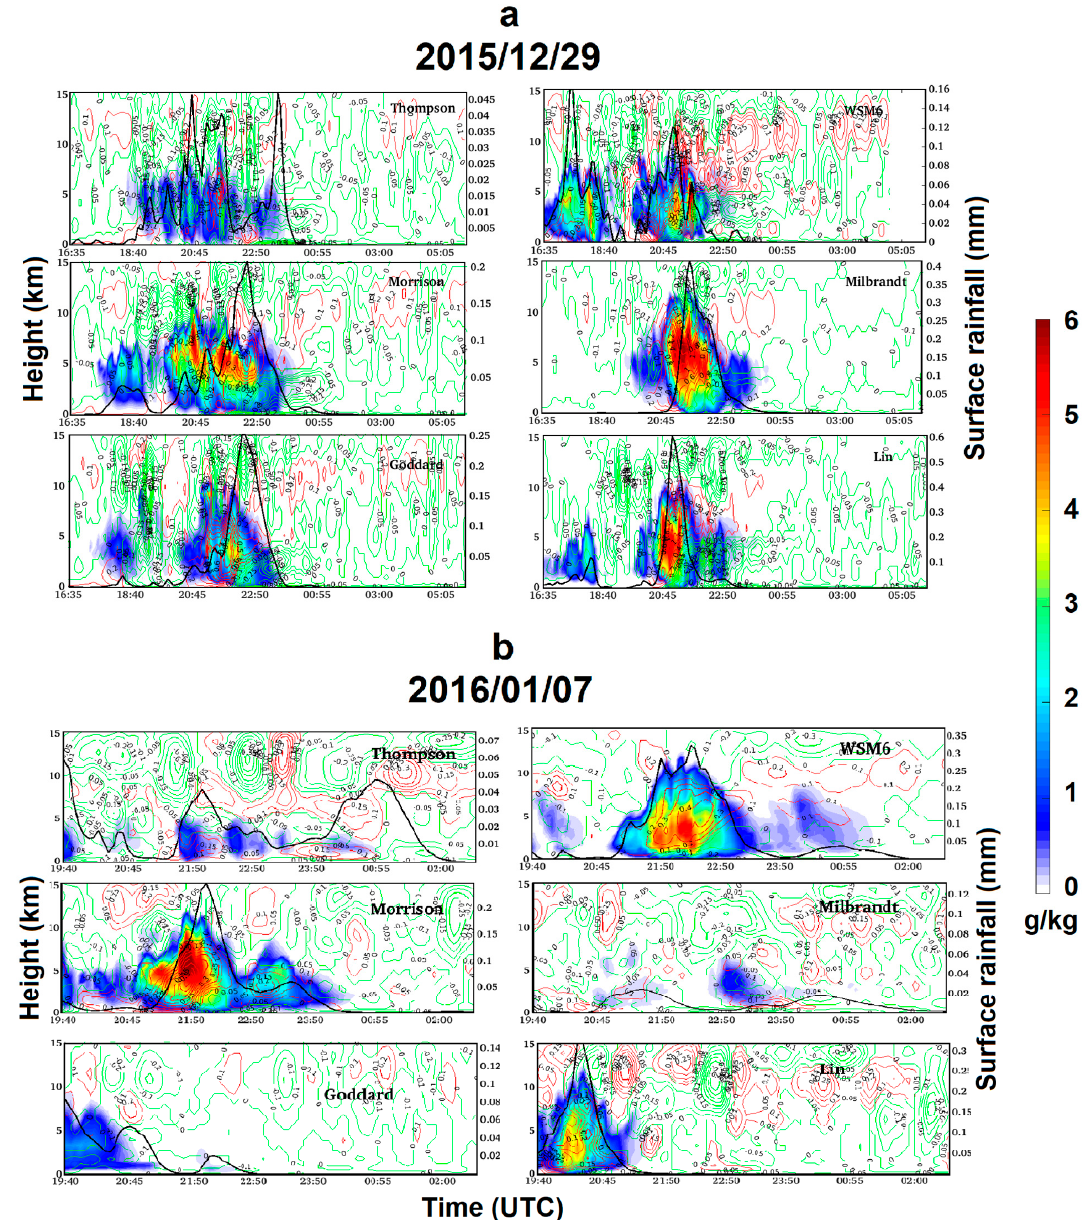
Figure 10. Temporal evolution of averaged graupel mixing ratio (shaded) with altitude for convective rainfall events. Contour lines show the averaged vertical velocity. The averaging area is a 10 × 10 m square centered in HYO. ( a ) CRE1. ( b ). CRE2